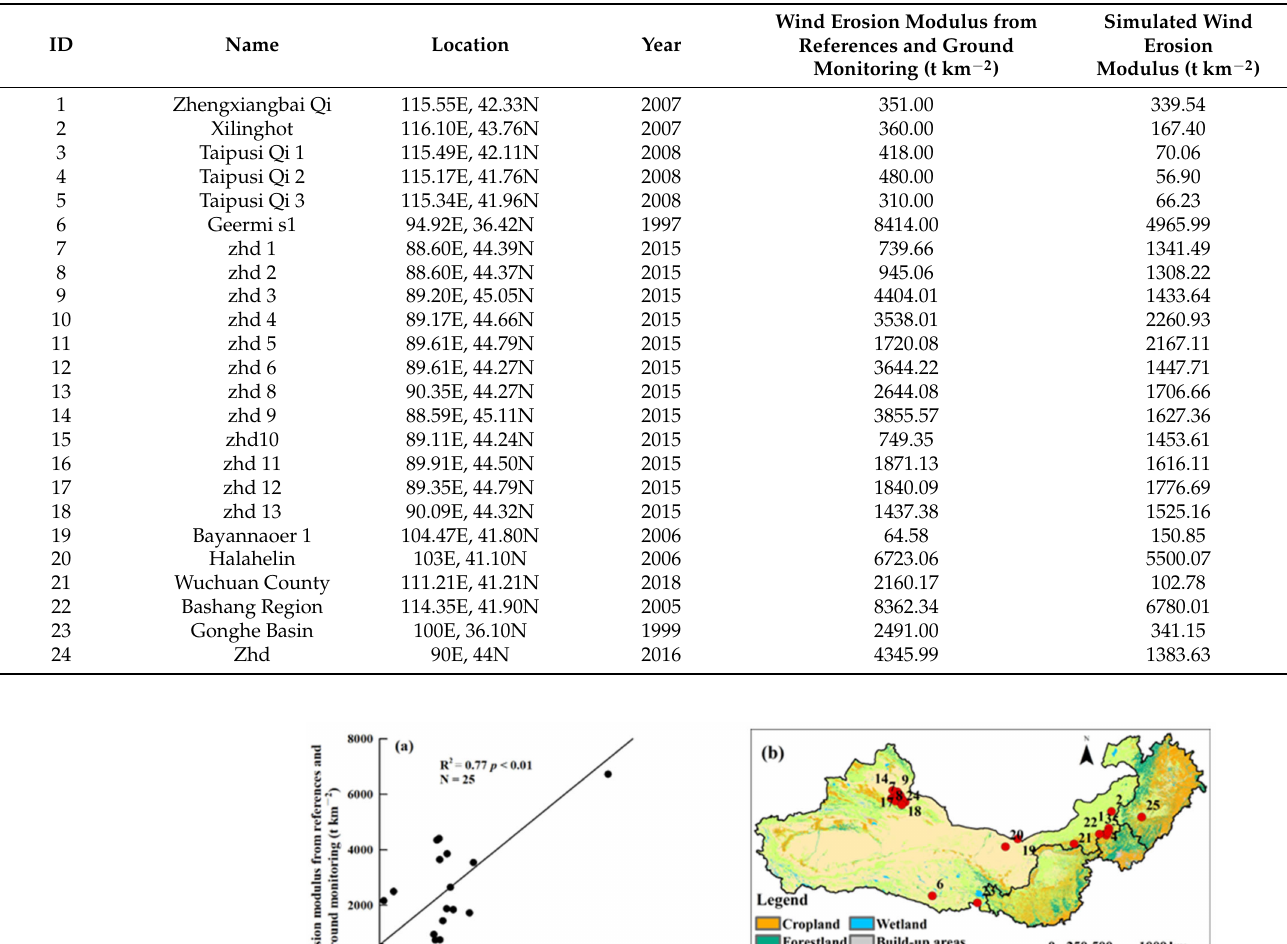
Table 1. Wind erosion modulus from published papers and field observations.